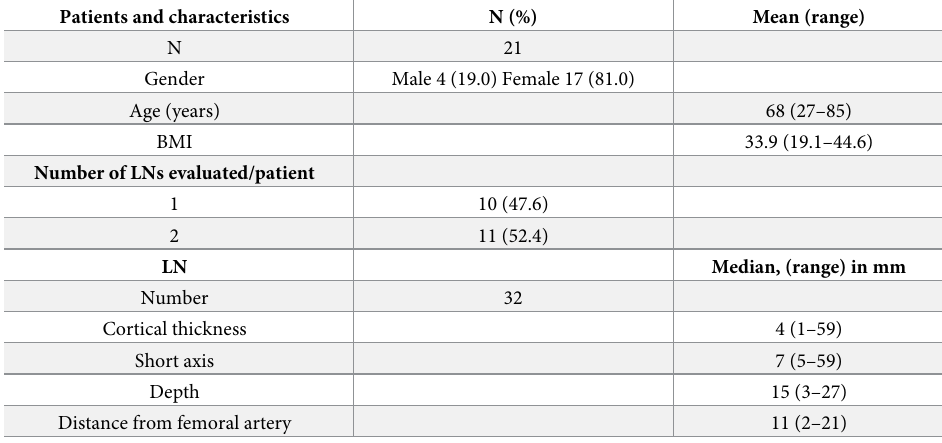
Table 1. Patient demographics and lymph node (LN) characteristics.